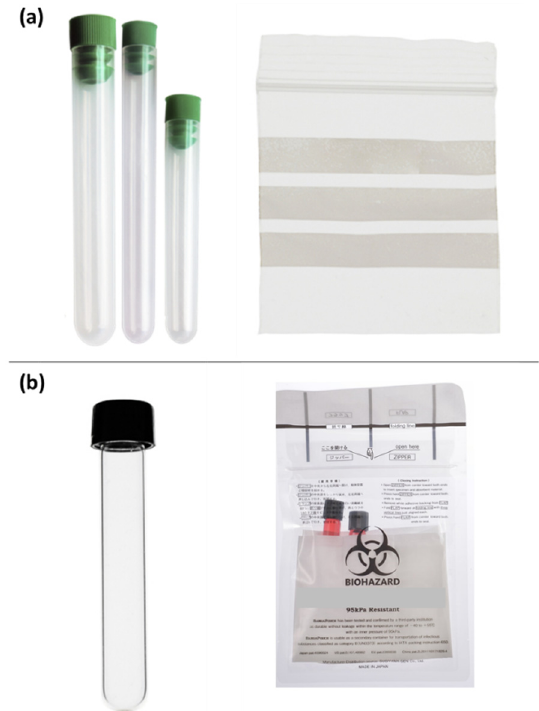
Figure 7. Primary receptacles for infectious samples ( a ) not meeting the test and ( b ) meeting the test of overpressure of +95 kPa.